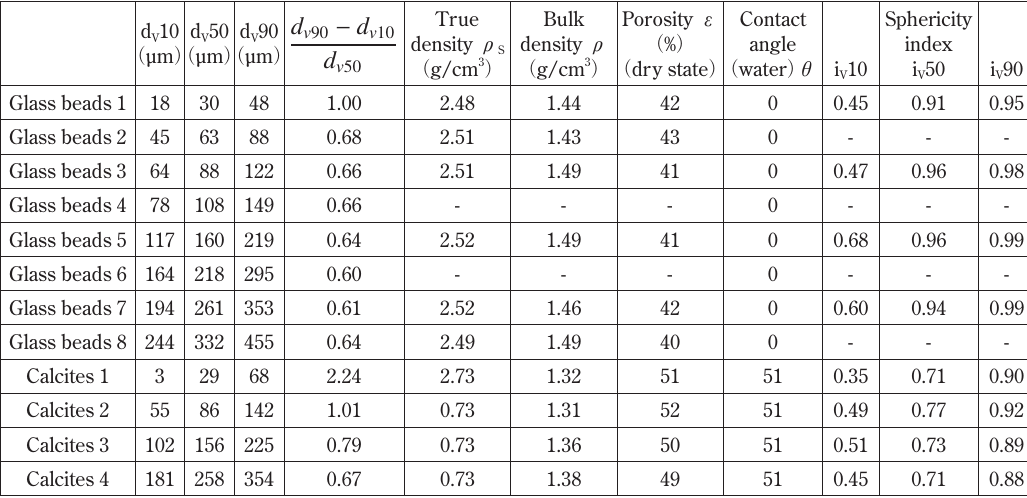
Table 1 Solids properties